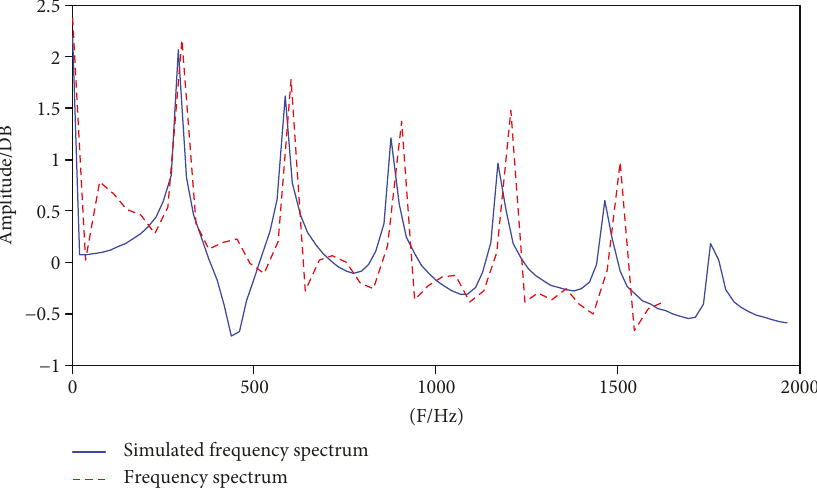
Figure 10: Matching result of sample 3 voice source in the frequency